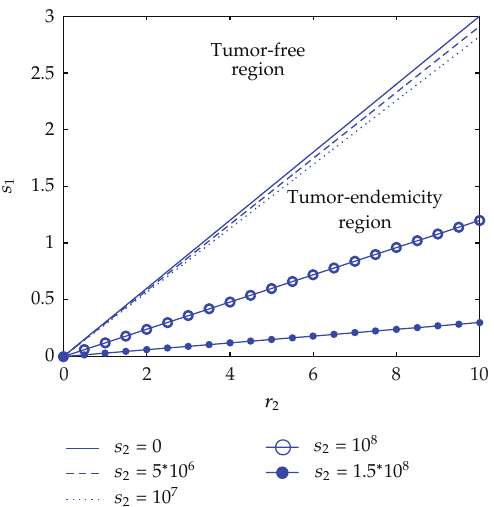
Figure 7: The critical s (cid:9) as a function of r 2 for several levels of s 2 . For values of s 1 above the threshold s (cid:9) 1 the tumor cells do not exist (cid:4) with α (cid:8) 0 . 5556 (cid:5) , see Table